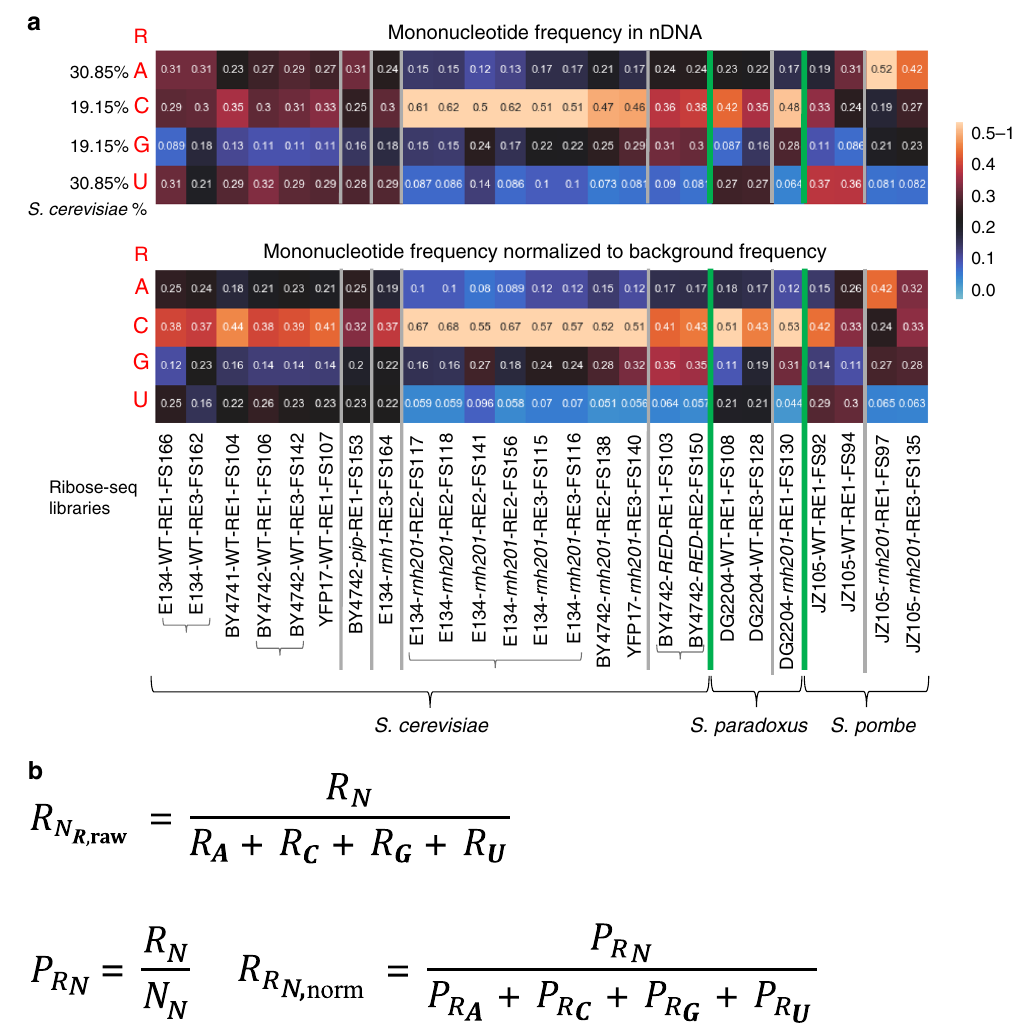
(Supplementary Fig. 8A, B). The MEME analysis covered three nucleotides upstream and three downstream from the rNMP site.